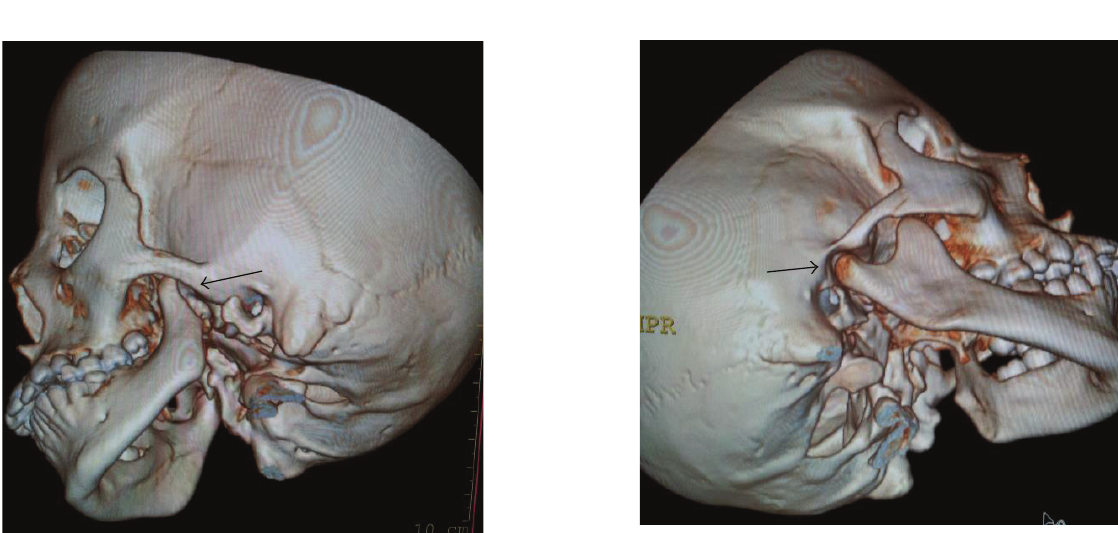
Figure 5: 3D CT scan of affected side (left) with missing condyle and glenoid fossa.